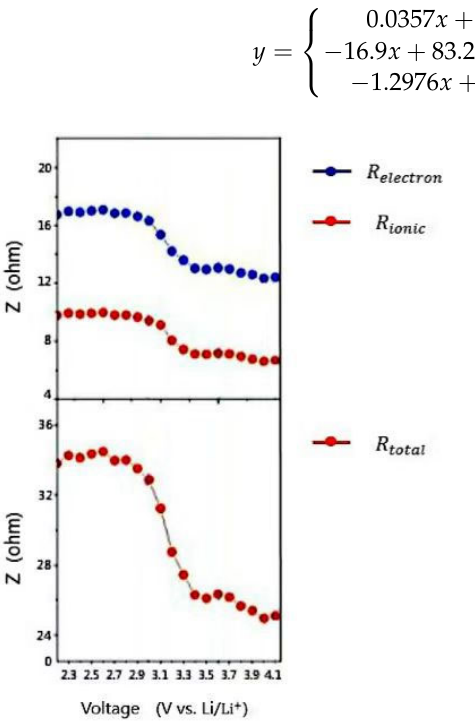
Figure 2. Electrochemical impedance spectroscopy of HyLICs. The electronic impedance, ion impedance and total impedance of the HyLICs changed with terminal voltage are shown in Figure 3. It can be seen that for the total impedance of the HyLIC, its nonlinear and time ‐ varying characteristics are quite obvious and it is inappropriate to adopt one method to estimate its SOC during different energy storage conditions. The standard Levenberg–Marquardt method [30] and general global optimization algorithm are used to perform piecewise linear fitting to the total impedance of the HyLICs, and the mathematical relationship is shown in Equation (1).